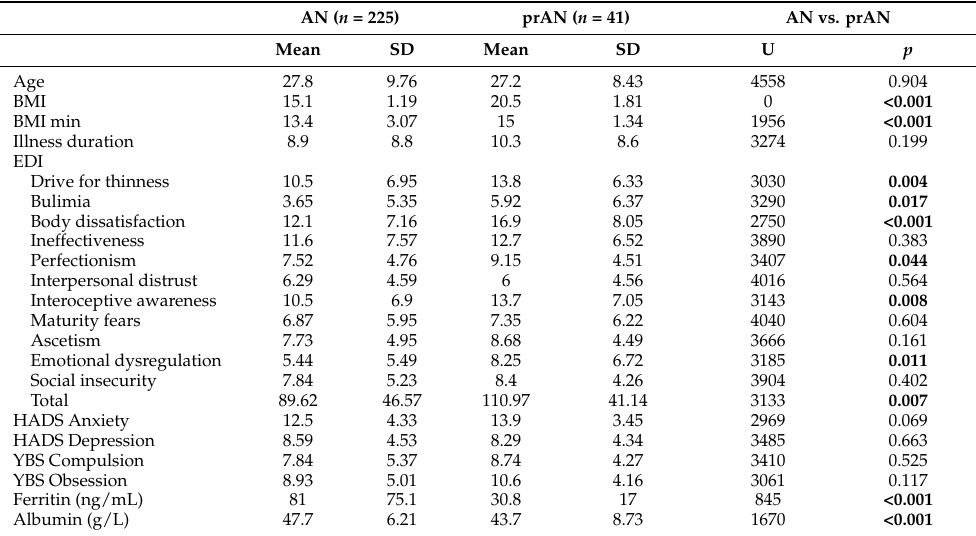
Table 2. Clinical characteristics of Anorexia Nervosa patients (AN) and partially recovered AN (prAN). Significant p -values are in bold.